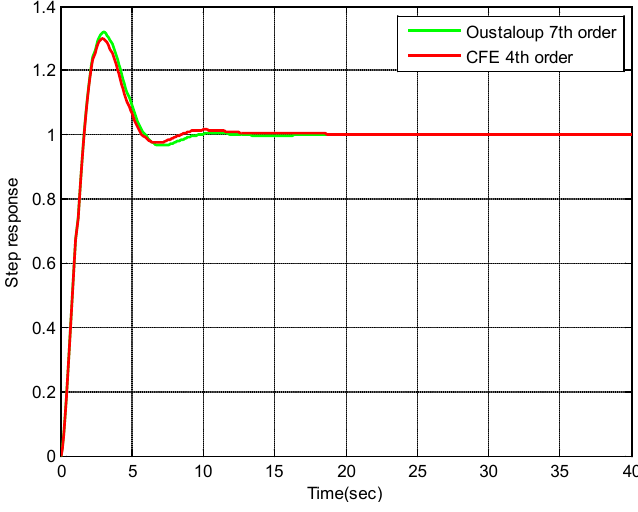
Figure 5. Step responses using the fourth order approximation given in Equation (9) and seventh order Oustaloup